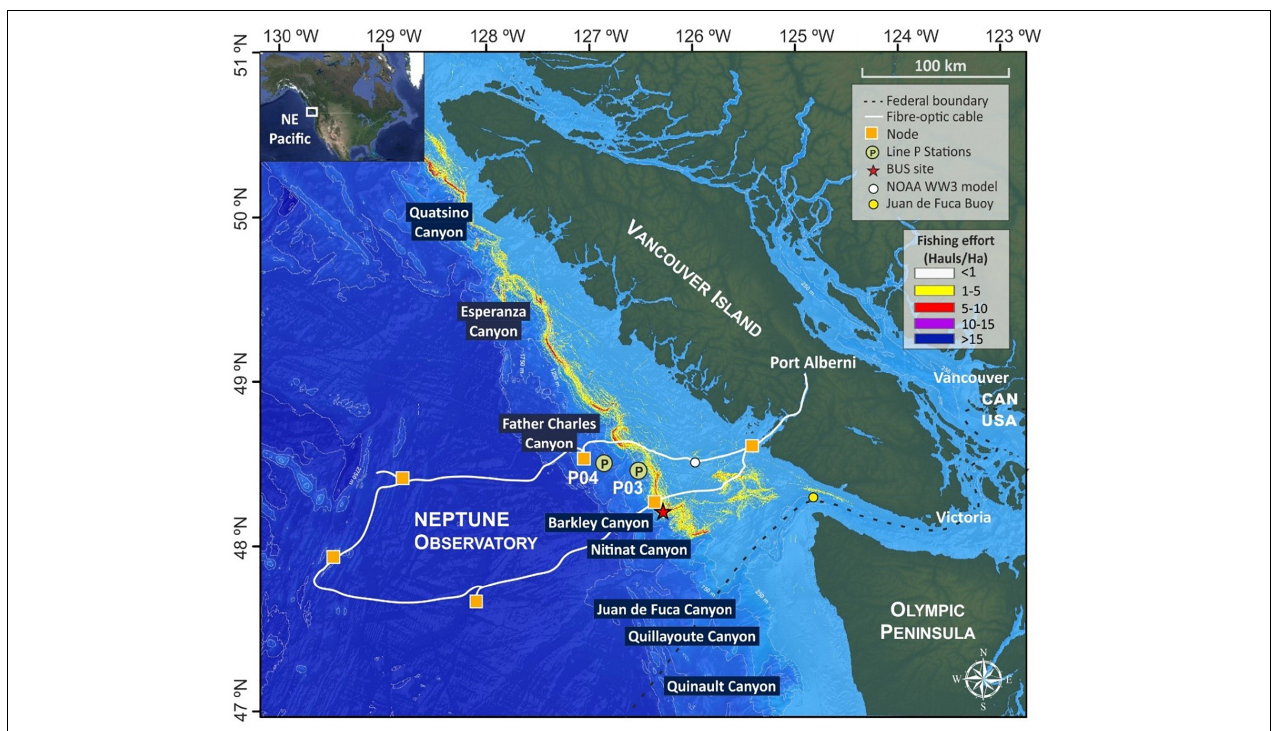
FIGURE 1 | Bathymetric map of the study area highlighting Ocean Networks Canada’s NEPTUNE cabled seafloor observatory (white line) and nodes (orange squares) and the submarine canyons incising the Cascadia margin. The location of the instrumented platform used in this study (BUS site) is illustrated with a red star and the long-term monitoring stations from Line P (P03 and P04) monitoring program are indicated in green circles. The location of the Juan de Fuca Buoy (yellow dot) and the NOAA WW3 model (white dot) are also shown, from which meteorological (wave and wind conditions) data were retrieved. The overlying density raster represents an estimate of the trawling effort on the Canadian territorial slope waters based on the number of hauls per hectare obtained from Automatic Identification System (AIS) data of 2018, which includes the monitoring period from the 14th of August to the 23rd of November (note that the map does not include trawling data from the United States territorial waters). For interpretation of the references in color in this figure legend, the reader is referred to the web version of this